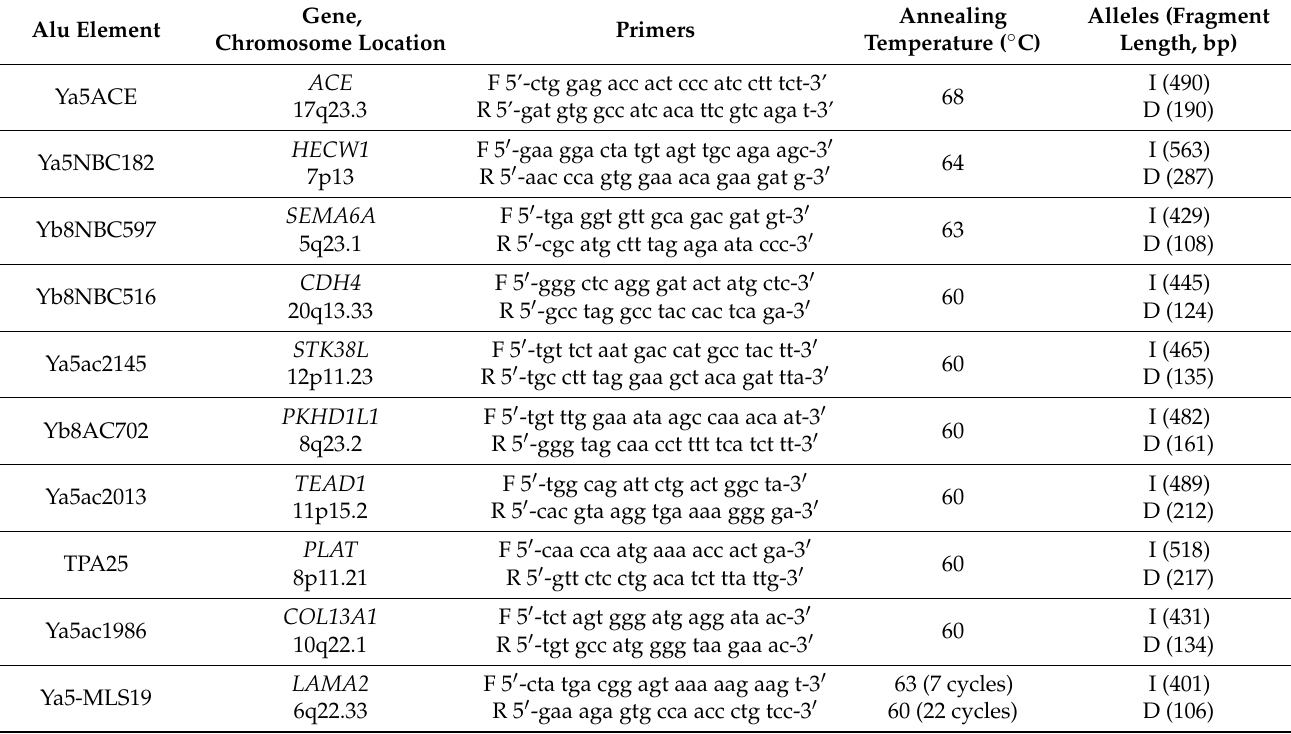
Table 5. Nomenclature, genetic localization, amplification conditions and length of the amplificated alleles for the studied Alu polymorphic